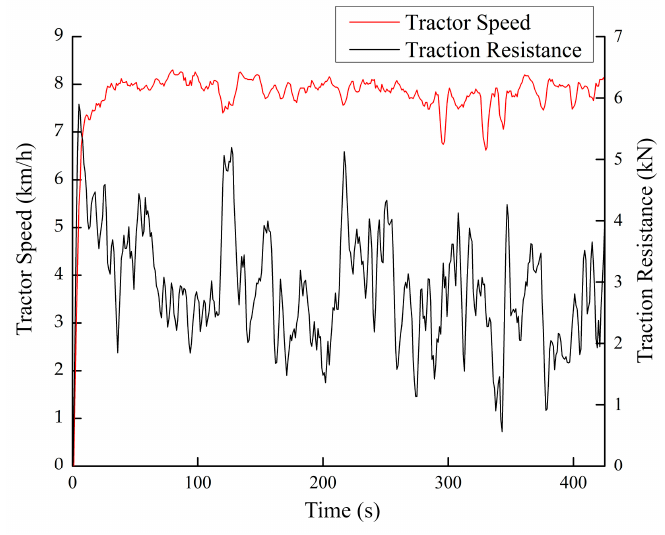
Figure 7. Plowing cycle for an agricultural tractor.